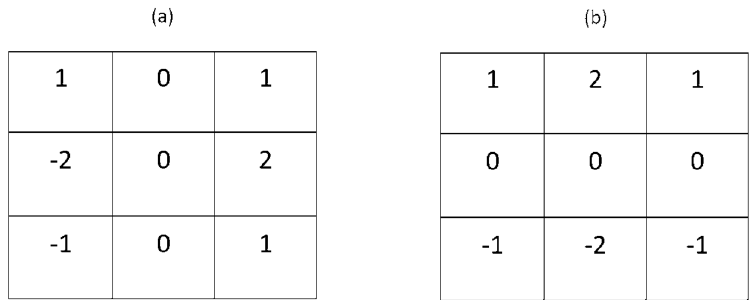
Figure 6. Image enhancement using different designs of Sobel templates: ( a ) horizontal and ( b ) vertical kernels.